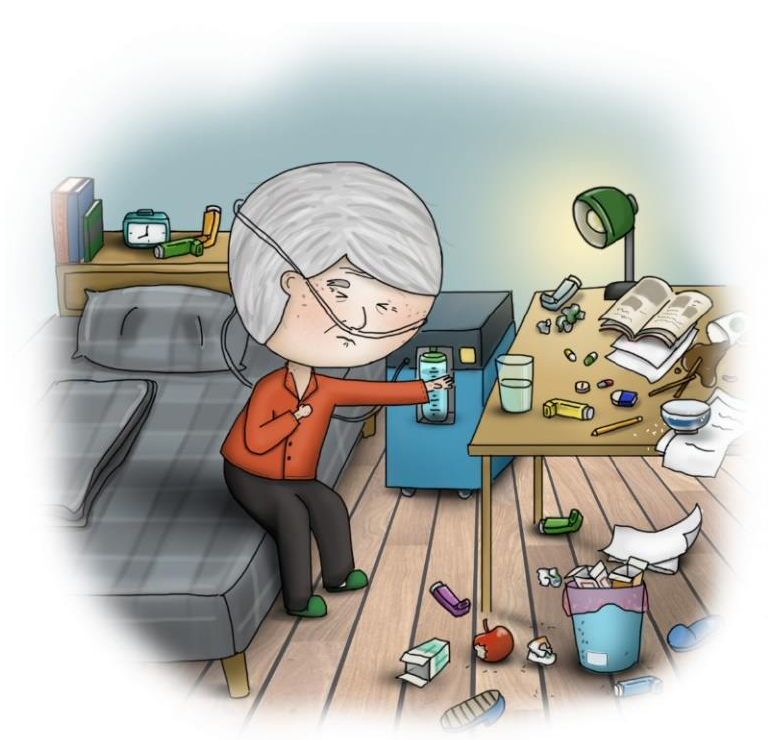
Figure 3. Persistent dyspnea.